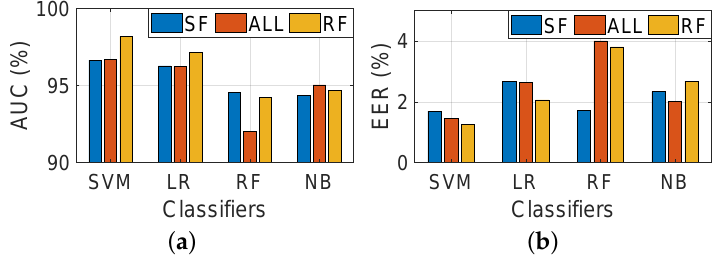
Figure 8. ( a ) AUC and ( b ) EER for different classifiers.